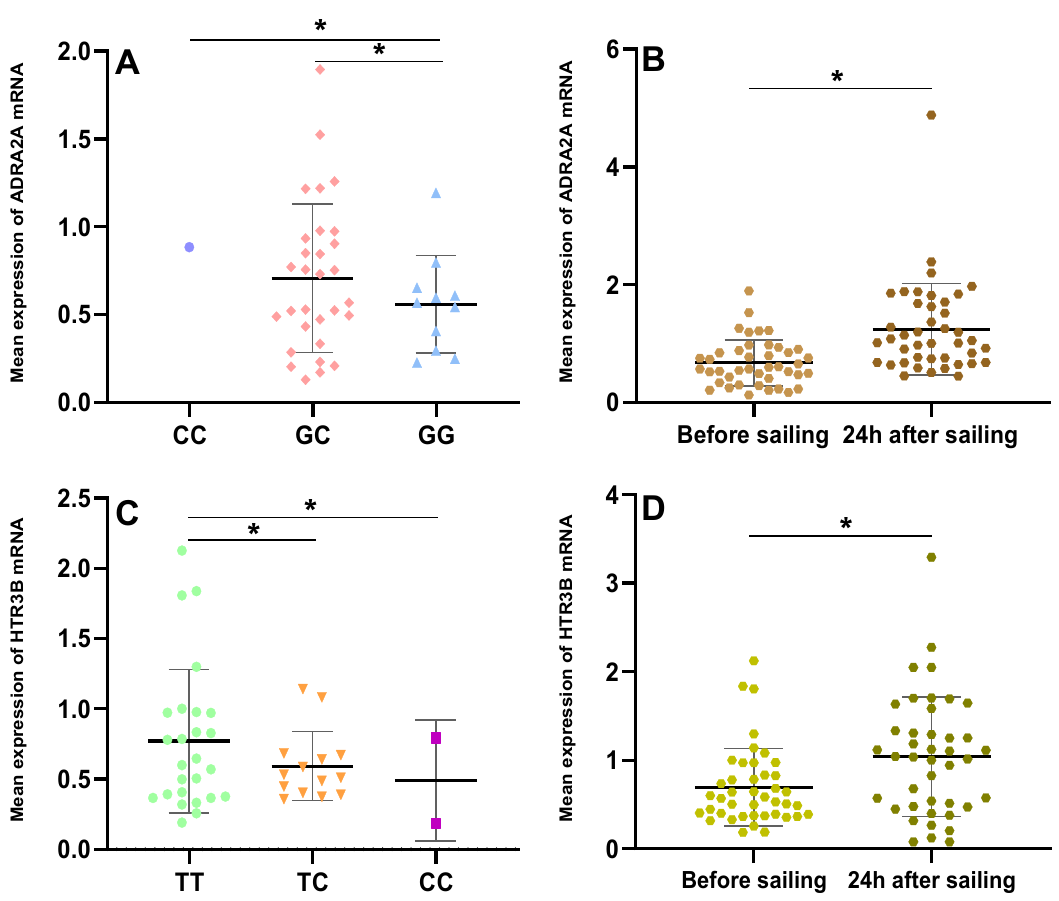
Figure 3. Basic level and changes within 24 h of ADRA2A and HTR3B mRNA in subjects in different genotypes. ( A ) Basic ADRA2A mRNA level in different rs1800544 genotypes; ( B ) Changes of ADRA2A mRNA level during 24 h of voyage in all subjects; ( C ) Basic HTR3B mRNA level in different rs3758987 genotypes; ( D ) Changes of HTR3B mRNA level during 24 h of voyage in all subjects. * p < 0.05; error bar: Standard Deviation (SD).